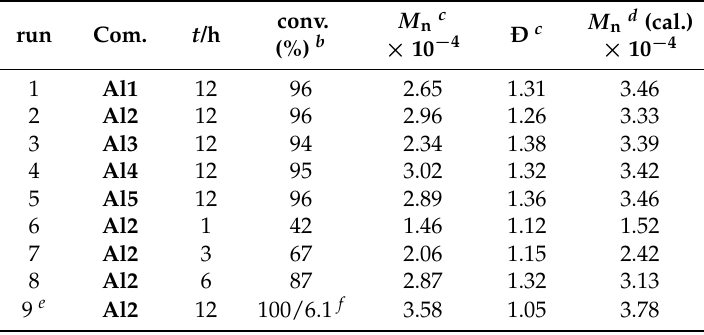
Table 2. Homopolymerization ROP of rac -LA by Al1 – Al5 /BnOH a .